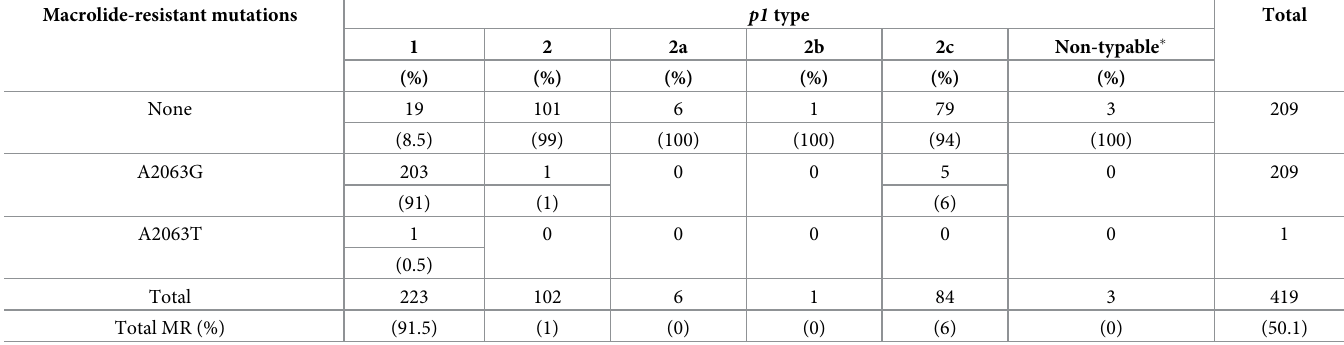
Table 4. Distribution of MR mutations in M . pneumoniae isolates of different p1 types. Macrolide-resistant